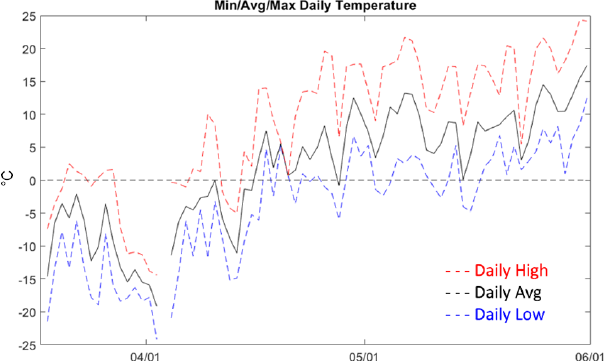
Figure A1. Daily high, average, and low air temperature at tailings pond site during spring 2020.